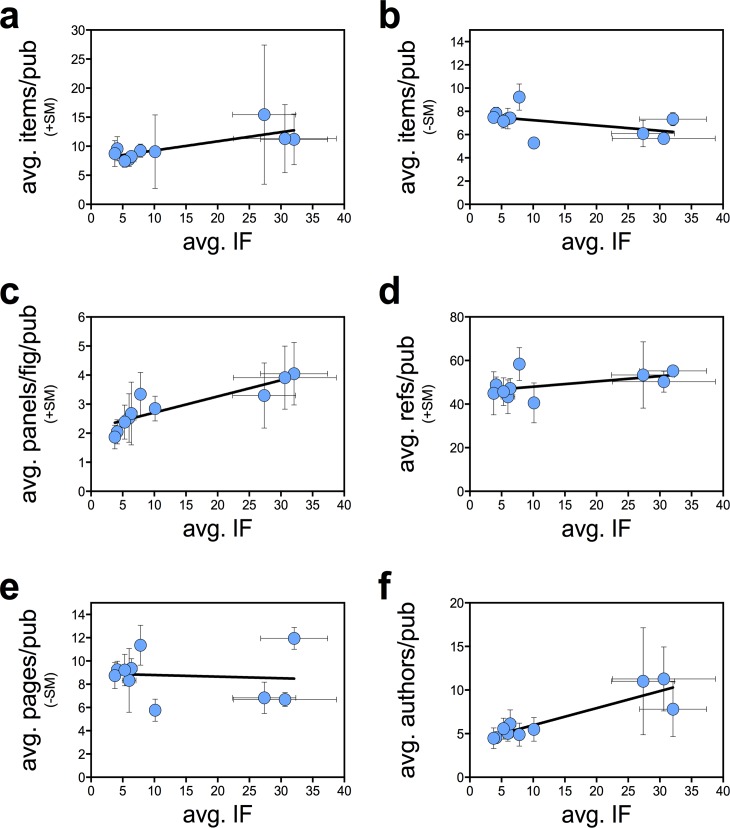
Correlation between the APU variables and journal’s average IF.Linear regression and Spearman’s rank-order correlation (Spearman’s critical rho (N = 10, alpha = 0.05) = 0.648) analysis of average IF and average number of (a) total data items (including supplemental material, +SM) (R2 = 0.14, p = 0.04; Spearman’s rho = 0.65, p = 0.05): (b) data items in main article alone (-SM) (R2 = 0.17, p = 0.03; rho = -0.56, p = 0.10); (c) PPF (R2 = 0.40, p = 0.0002; rho = 0.96, p<0.0001); (d) pages (R2 = 0.01, p = 0.71; rho = -0.08, p = 0.84); (e) references (R2 = 0.10, p = 0.08; rho = 0.50, p = 0.14); and (f) authors (R2 = 0.44, p<0.0001; rho = 0.81, p = 0.007) per publication. Error bars represent standard deviations.